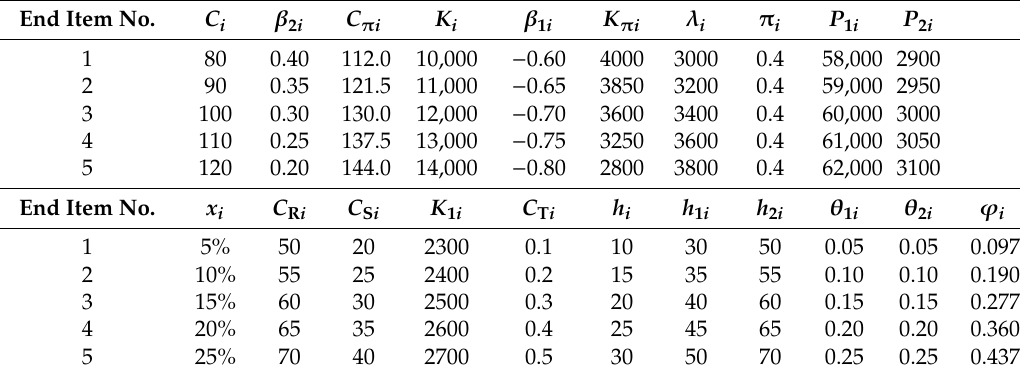
Table 2. Values of system parameters of our